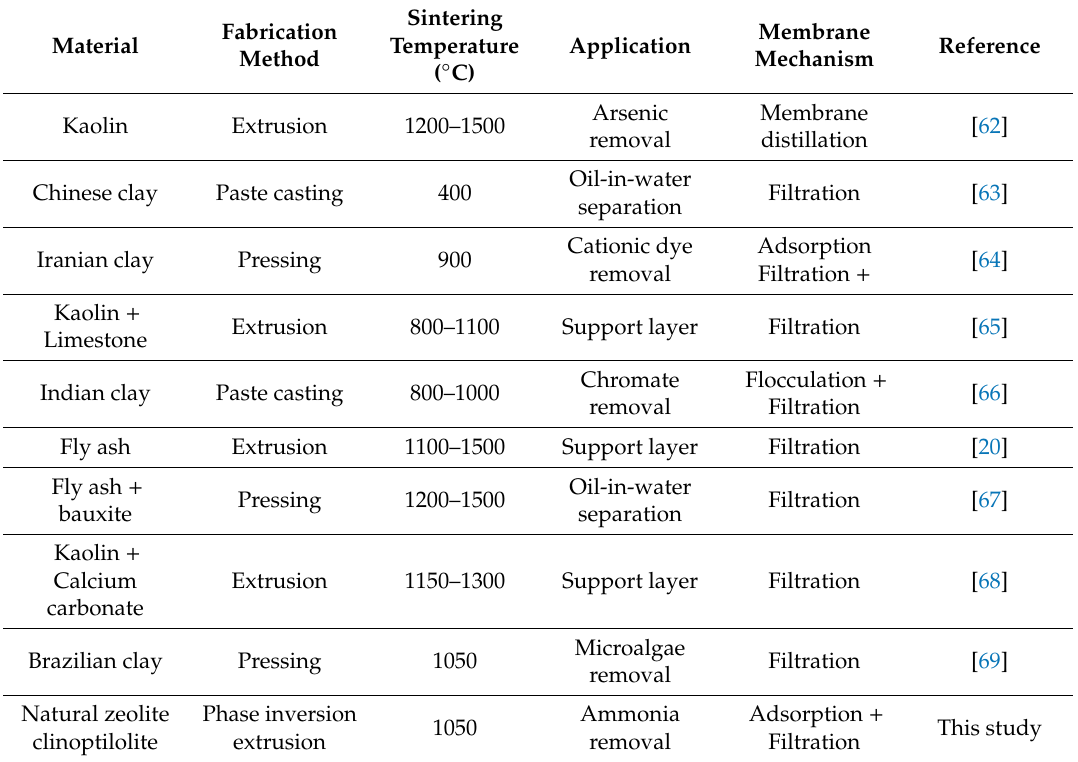
Table 2. Low-cost membranes and its